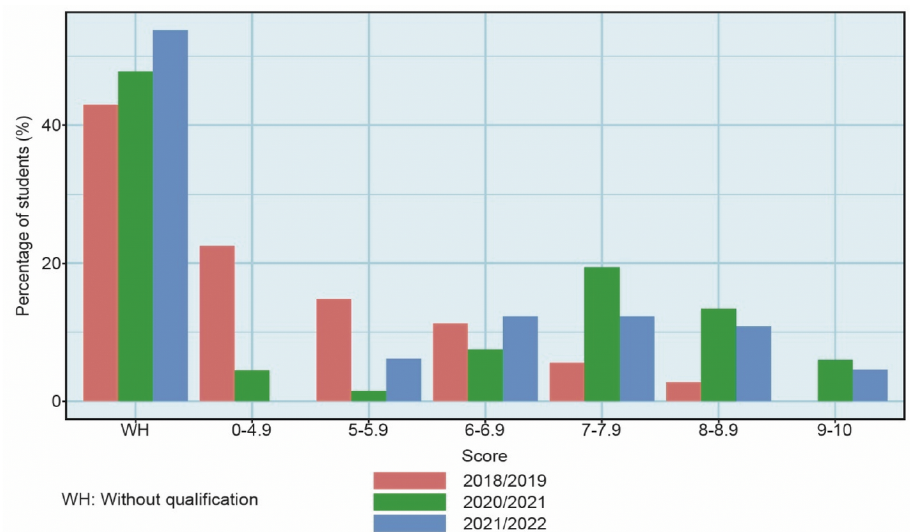
Figure 4. Comparison of the percentage of students according to the marks obtained